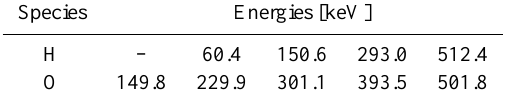
Table 1. During the measurements, the responses of all 16 detectors to the various beams were determined (see Figs. 7 and 8), and the corresponding output pulse heights from the NUADU amplifiers were recorded using a multi-channel analyser (for details, see McKenna-Lawlor et al., 2004). For 150 keV Hydrogen, the energy resolution at FWHM was, thereby, found to be 8%. For 300 keV Oxygen, the corre- sponding resolution was